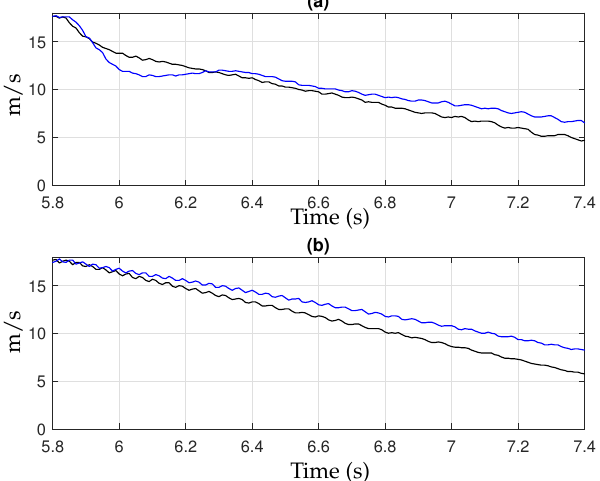
Figure 5. ( a ) Wheel velocity v w : a modified HOSM controller using PID-sliding surface (14) (black) or PID-like controller (26) (blue) and ( b ) vehicle longitudinal velocity v x : a modified HOSM controller using PID-sliding surface (14) (black) or PID-like controller (26) (blue).